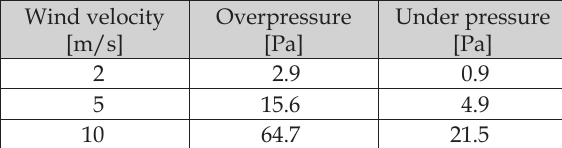
Table 4. values of overpressure and under pressure Table 3. Amounts of Co , water vapor and heat that 2 in relation to wind velocity (Krasniqi et al. person releases within an hour (Krasniqi et al. 2004).